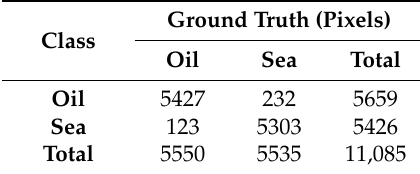
Table 6. Confusion matrix achieved by ANN based on 9 fully polarimetric features.